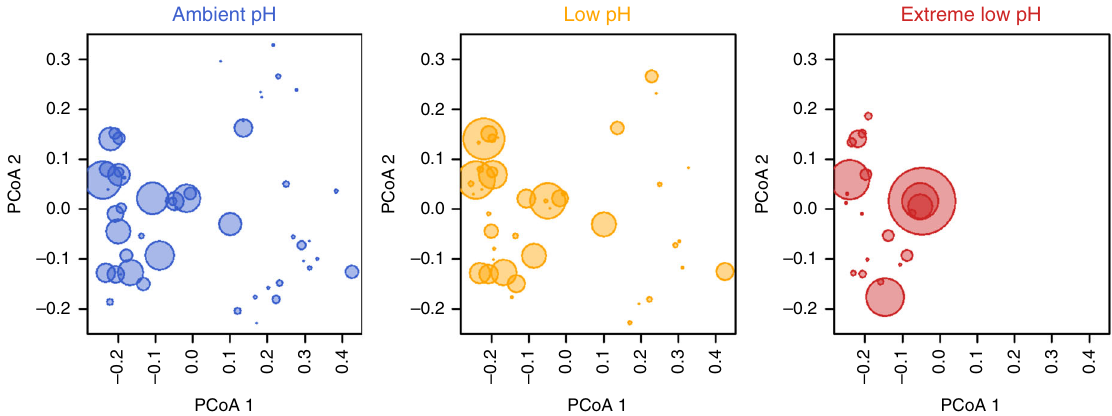
Fig. 2 Overall distribution of FE abundance across the functional space. Each point represents a functional entity (i.e. unique combination of functional attributes) and the size of the circles is proportional to the relative cover of the species belonging to a certain functional entity. Number of species =